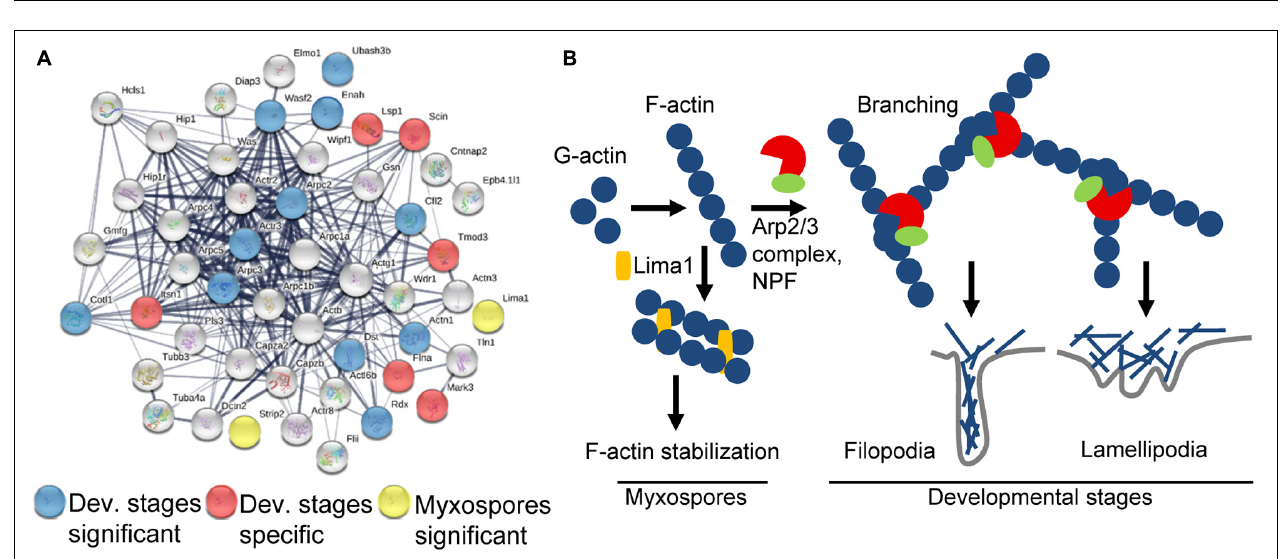
FIGURE 4 | STRING GO enrichment analysis of molecular function of significantly expressed proteins in either developmental stages or mature myxospores. Only terms that were associated with at least 10 proteins are shown; FDR adjusted P < 0.05. (A) GO terms enriched in developmental stages. (B) GO terms enriched in myxospores. (C) Enriched GO terms shared by both sample types. Detailed results of the GO analysis are in Supplementary Table 4 .